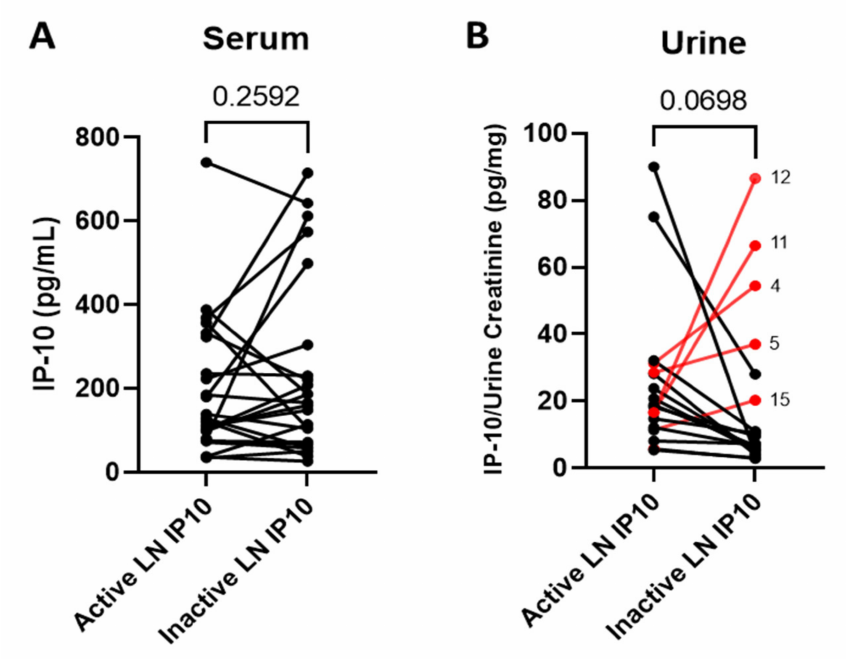
Figure 2. Urinary IP-10 decreases with remission in LN. ( A ) LN patient serum IP-10 levels from an active disease collection date compared to an inactive (remission) disease collection date; ( B ) urine levels of IP-10 of active and remission samples available from the same patient and collection dates as 2A ( n = 18; Two-Tailed Ratio T-Test). Patients with an increase in urine IP-10 during remission are highlighted in red and labelled with the patient number that correlates to Table